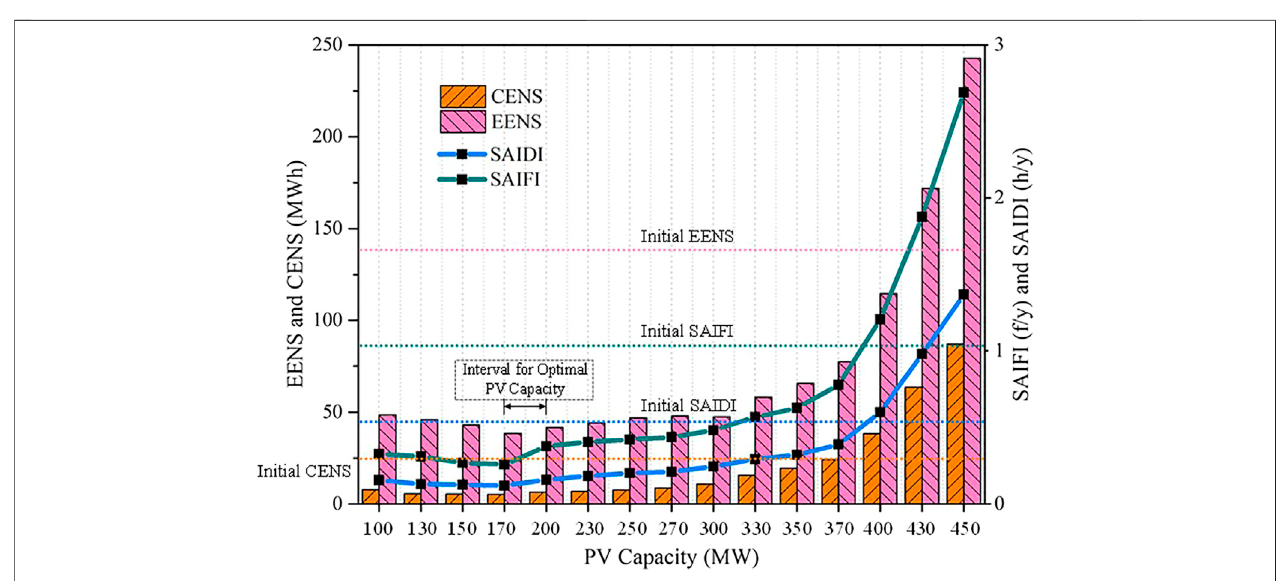
FIGURE 13 | Reliability indexes with PV integration-based capacity from 100 to 450